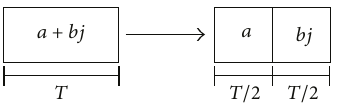
Figure 1: Complex to pure real and imaginary